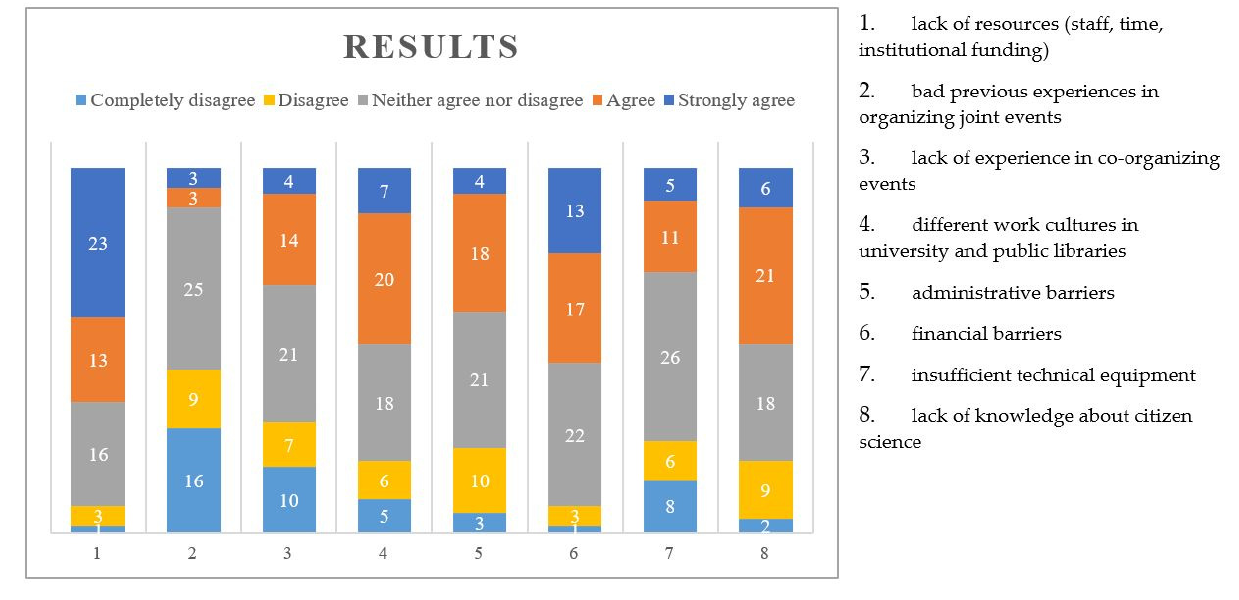
Figure 1. Results. Figure 1. Results.